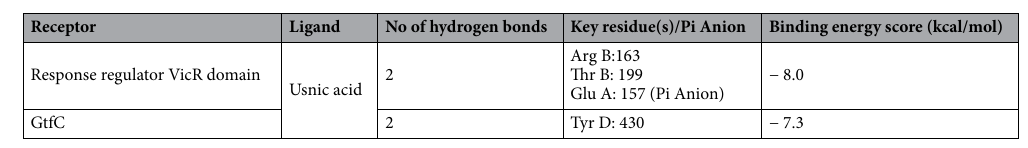
Table 1. Molecular interactions and binding energy identified through molecular docking analysis of UA with VicR and